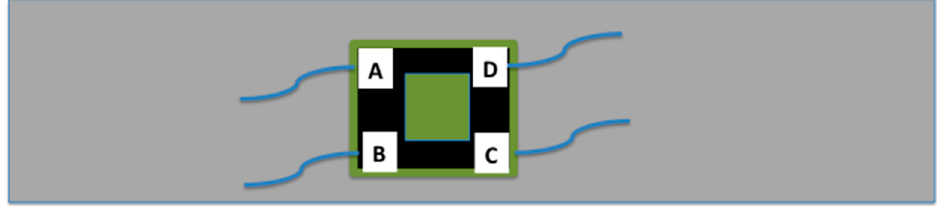
Figure 5. Uniaxial tensile specimens made with aluminum with a CNT bonded sensor, and electrodes at the corners (size of the sensor 20 × 20 mm). The black strips are the doped areas, 5 mm in width.